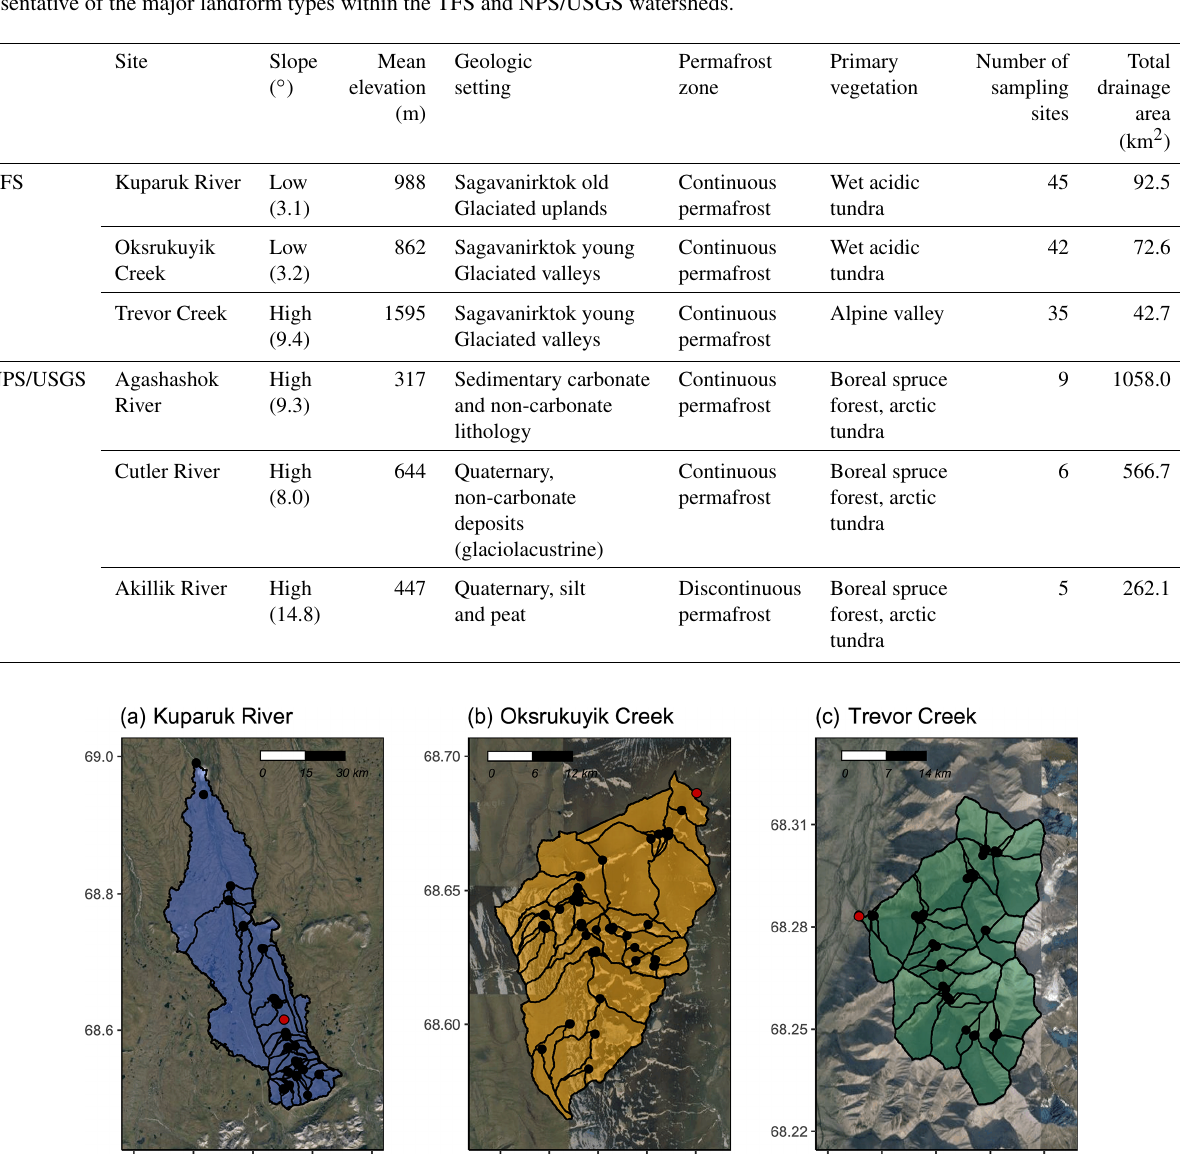
Table 1. Summary of site characteristics for the watersheds where synoptic samplings were conducted. The descriptions are considered representative of the major landform types within the TFS and NPS/USGS watersheds.